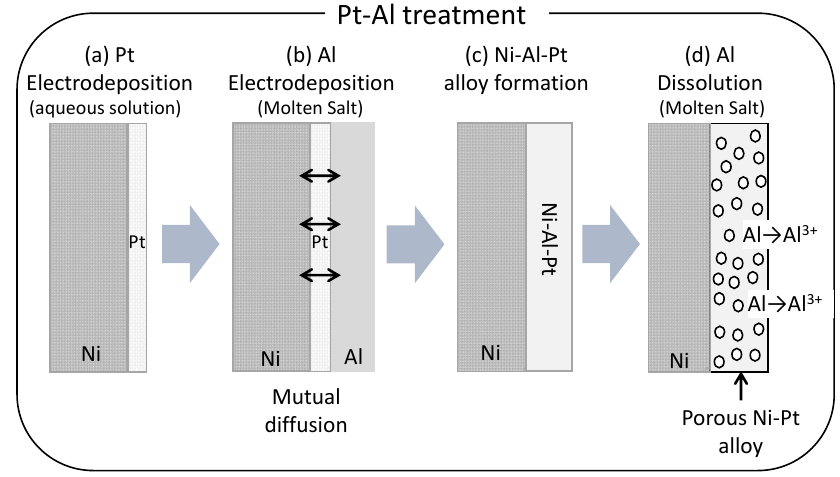
Figure 1. Method of the Ni–Pt alloy porous layer formation.